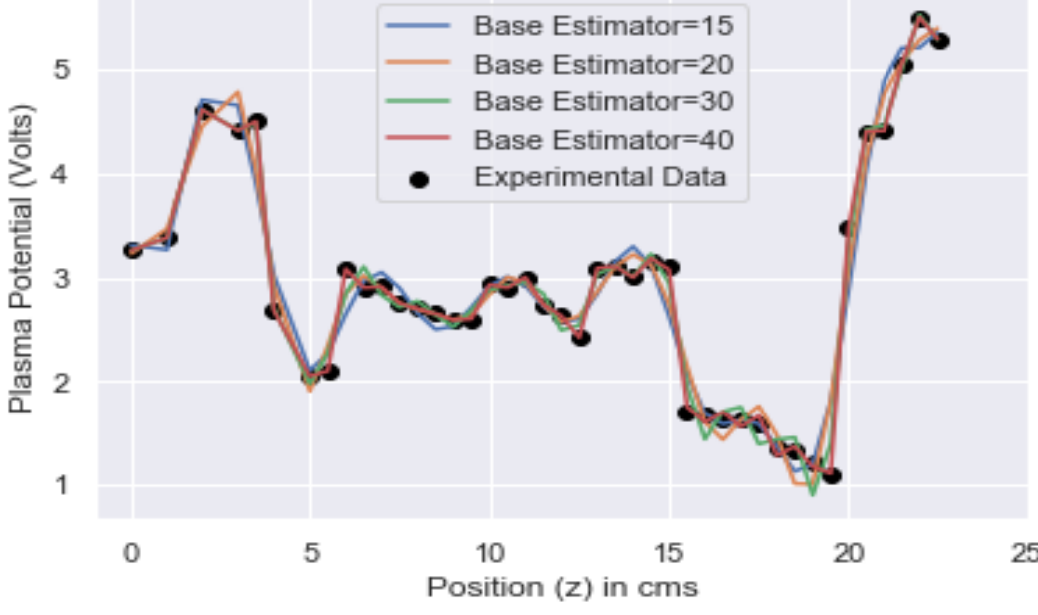
Figure 5. Prediction of axial plasma potential variation using GBF regression